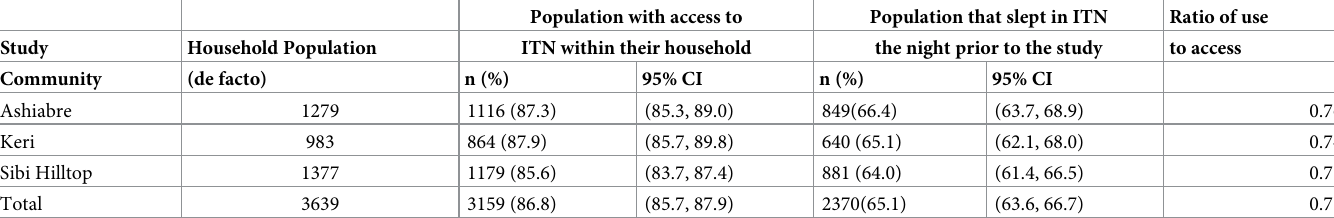
Table 8. Access to and use of LLINs by enrolled households in study communities.